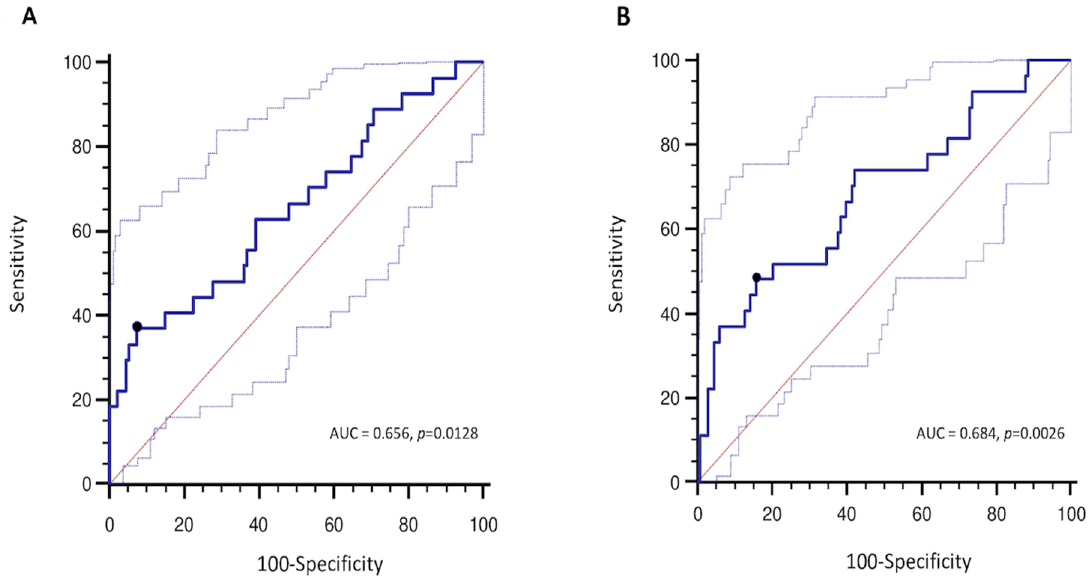
Figure 2. Receiver operator characteristics (ROC) curve analysis for GWI ( A ) and GCW ( B ) as a predictor of all-cause death.